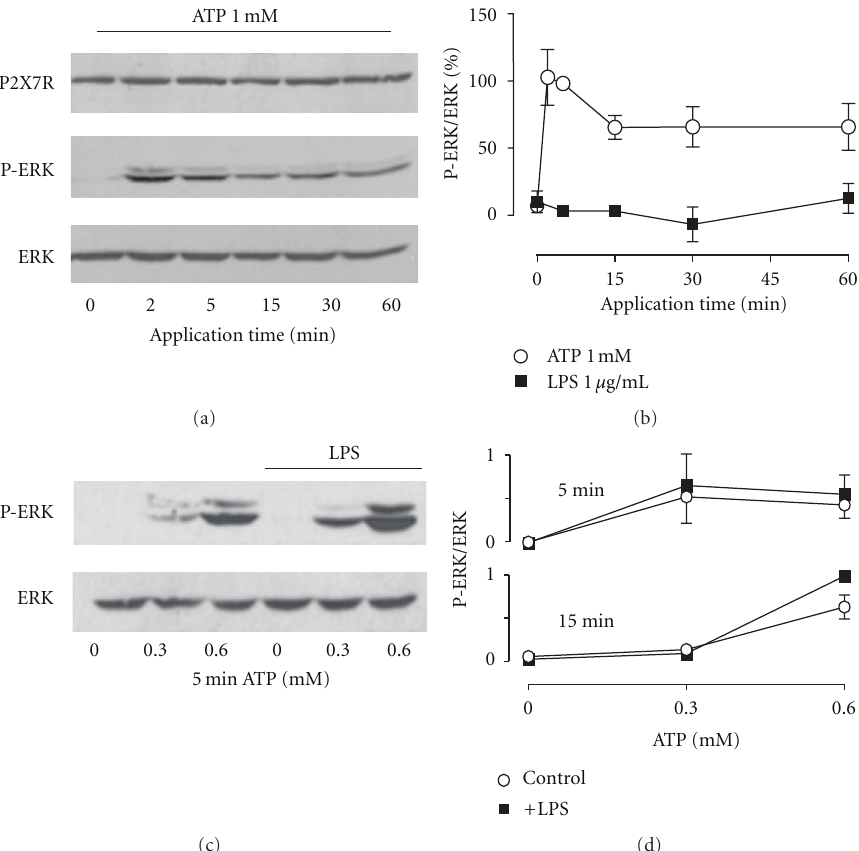
Figure 6: LPS does not a ff ect ATP-induced ERK activation in P2X7R-HEK293 cells. (a) Representative gel showing ERK phosphorylation (P- ERK, middle panel) induced by 1mM ATP applied at di ff erent times. The upper panel shows P2X7R immunoreactivity of stable transfected cells; the lower panel shows total ERK. (b) Quantification of the e ff ects on ERK activation obtained by the application of 1mM ATP (open circles) or 1 μ g/mL LPS (closed squares). Data were normalized against the phosphorylation induced by 2 min of ATP application, n = 6. (c) Representative gel showing control cells or pretreated with 1 μ g/mL LPS for 30min. ATP was applied for 5min, and ERK activation was evaluated. Upper panels show the detection of P-ERK; lower panels show total ERK. (d) Quantification of ERK activation in control (open circles) and LPS-treated (closed squares) cells at di ff erent ATP concentrations applied for 5 (upper graph) and 15 min (lower graph). Experiments were normalized against ERK phosphorylation induced by 600 μ M ATP for 15min in LPS-treated